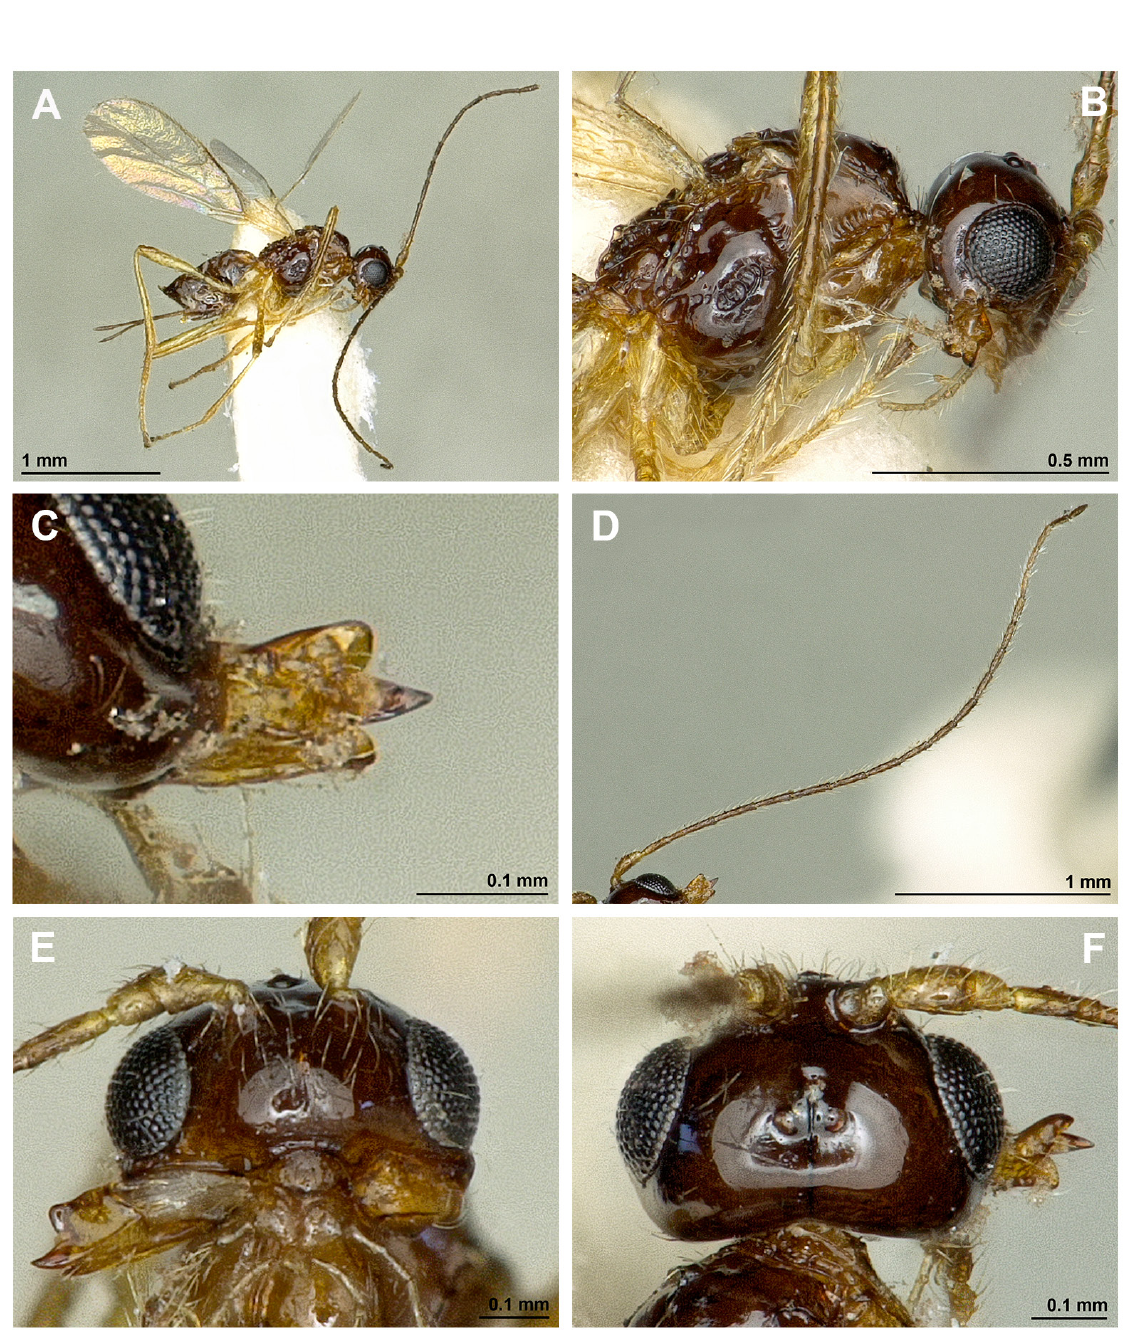
Fig. 23. Asobara harrinsmithensis Peris-Felipo, sp. nov., ♀, holotype (BMNH 1927-147). A . Habitus, lateral view. B . Head, lateral view. C . Mandible. D . Antenna. E . Head, front view. F . Head, dorsal